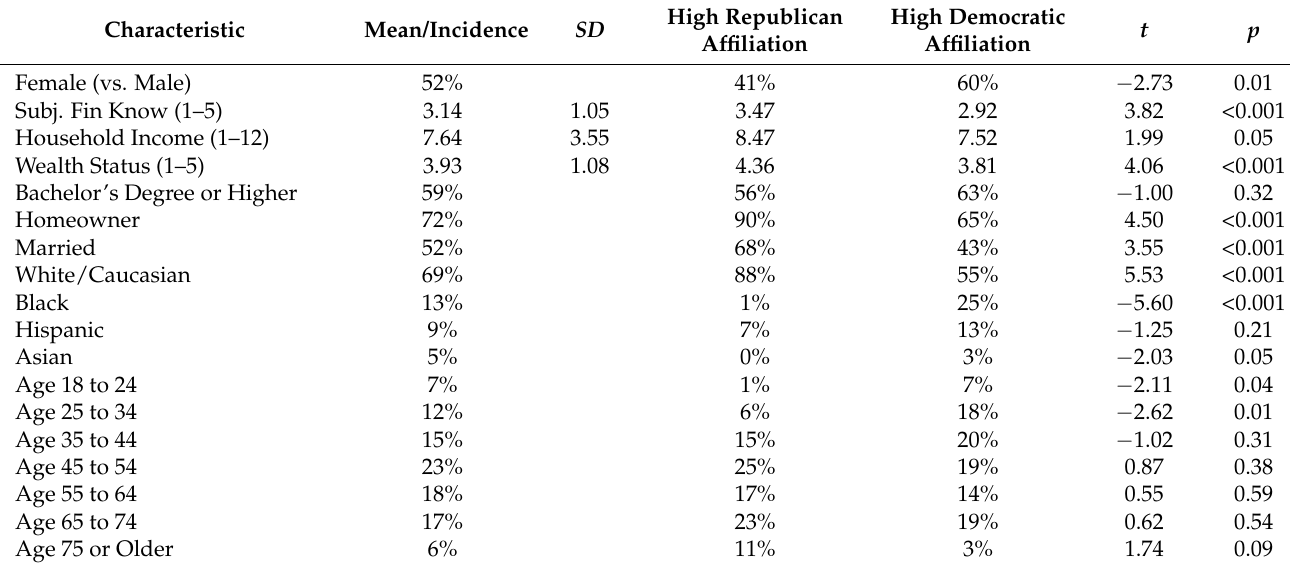
Table 3. Sample characteristics ( N = 407).